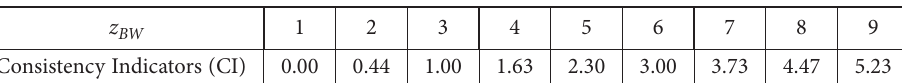
Table 2. Consistency indicators